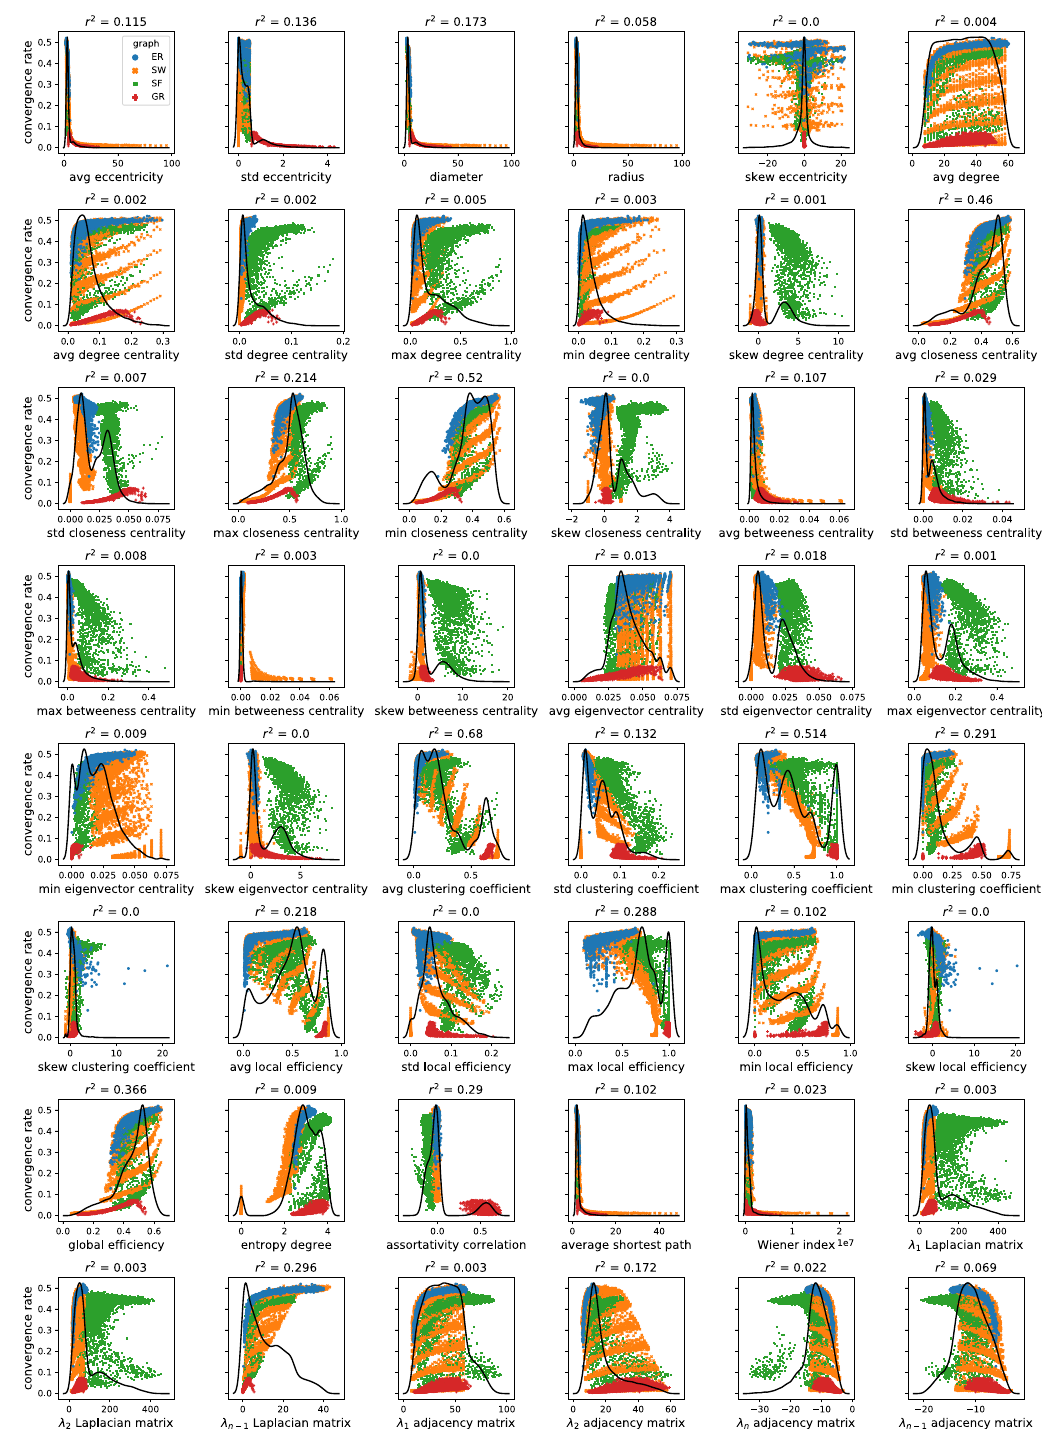
Figure 10. Scatter plots of graph metrics versus convergence rate in ER (blue), SW (orange), SF (green) and GR (red) graphs. The solid black line represents the distribution of the metric across all graph